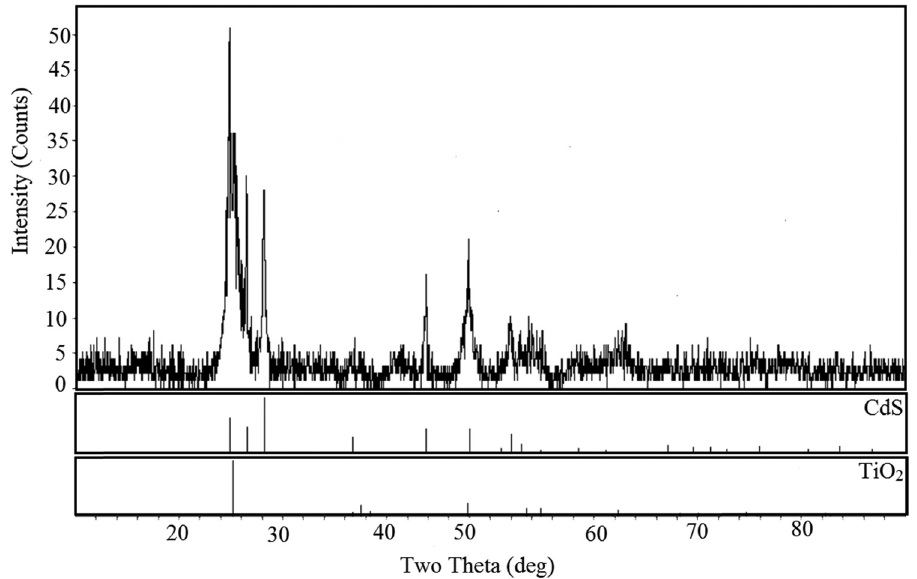
Figure 3: XRD pattern of CdS/TiO 2 composite photocatalysts with a material ratio of 25:75.